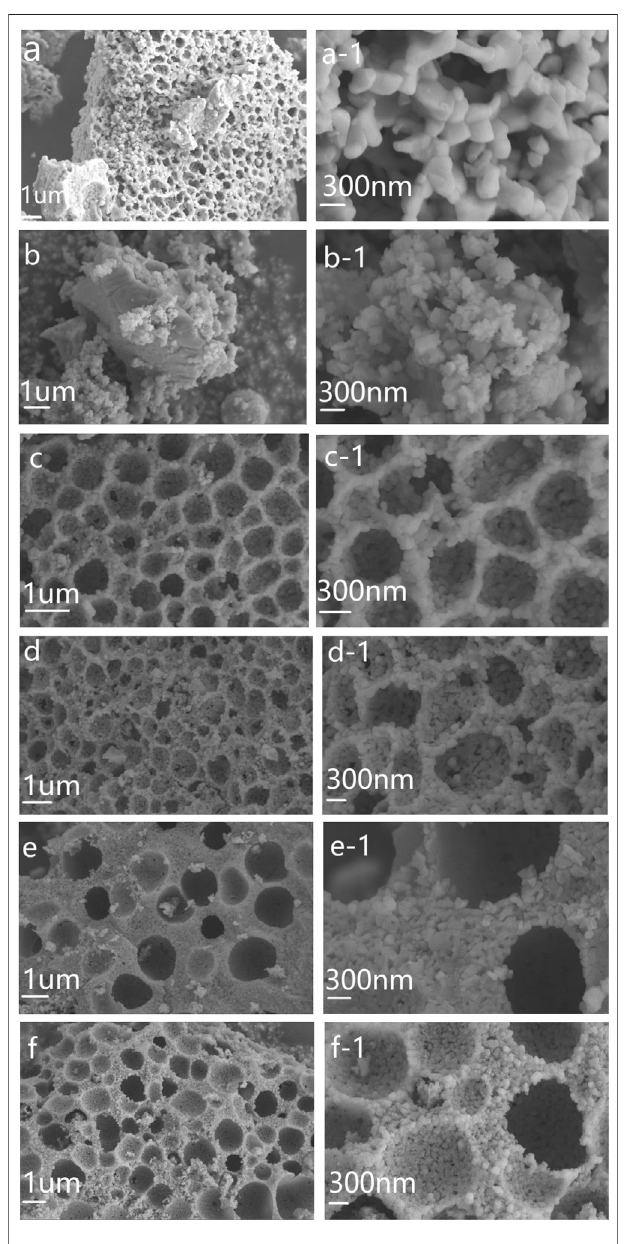
FIGURE 4 | SEM images of the Bi 1-x Nd x Fe 1-y Co y O 3 nanoparticles, magni fi edSEMimage. (A) BFO, (B) BNFO, (C) BNFCO-5, (D) BNFCO-10, (E) BNFCO-15, (F)